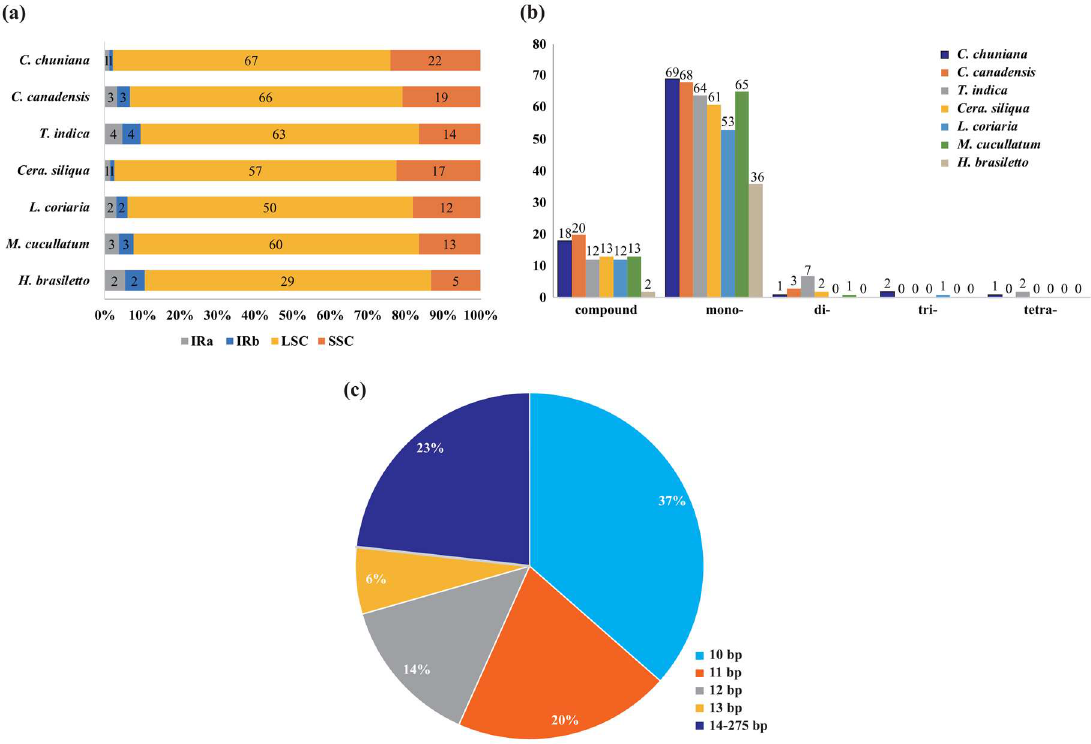
Figure 3. Analysis of repeated sequences of the seven species compared in this study. ( a ) The number of SSRs distributed in different regions; ( b ) The number of SSRs with different types, including compound, mono-, di-, tri-, and tetranucleotides; ( c ) The proportion of SSRs with different